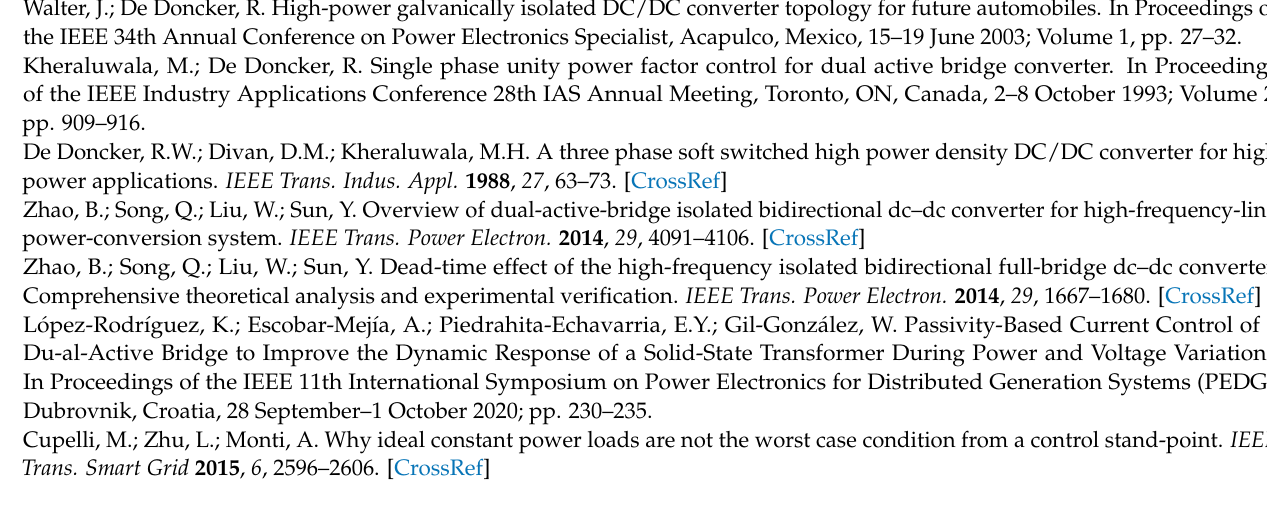
Figure 11. Waveforms in voltage reference step experiment.